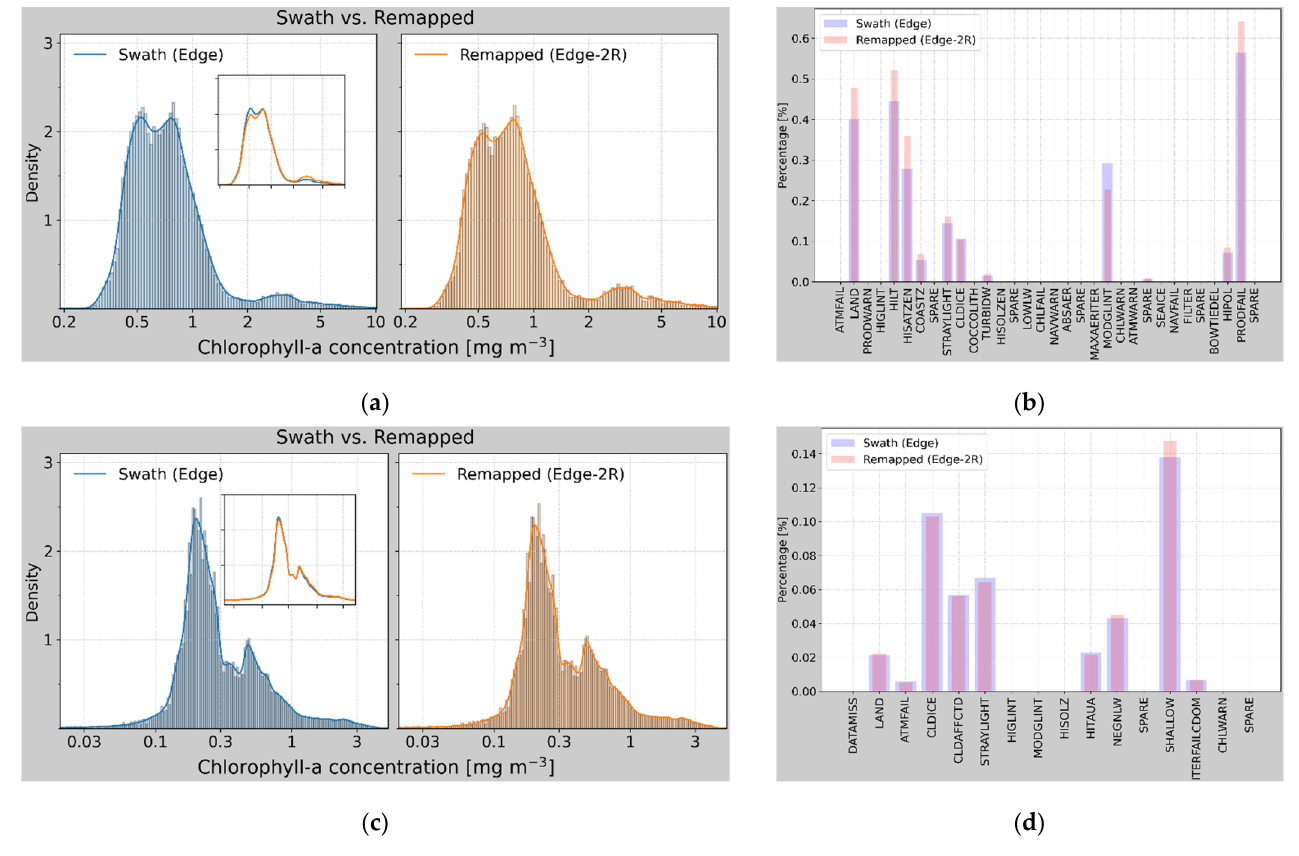
Figure 3. Density histogram of swath versus remapped image: ( a , c ) chlorophyll data and ( b , d ) the frequency distributions of associated quality flag information. ( a , b ) Diagrams were obtained from MODIS/Aqua data (Figure 2) and ( c , d ) from SGLI/GCOM-C data (Figure A6). These diagrams were created from the red polygons highlighted at the swath edge in the respective figures. The overlaid curves are the probability distribution functions (PDF) for the same samples. The inset compares the two PDFs (swath versus remapped). Note the increase in pixel number in the range of 2 to 10 mg m –3 associated with the high chlorophyll at the swath edge in ( a ). Description of MODIS/Aqua flags can be obtained from https://oceancolor.gsfc.nasa.gov/atbd/ocl2flags/, accessed on 29 July 2022. For more on SGLI/GCOM-C quality flags, see https://suzaku.eorc.jaxa.jp/GCOM_C/data/files/ATBD_